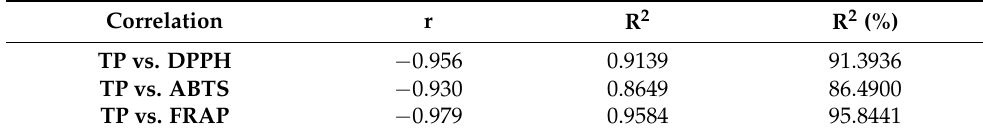
Table 14. Correlation coefficients between TP and antioxidant methodologies. Correlation r R 2 R 2 (%) TP vs. DPPH − 0.956 0.9139 91.3936 TP vs.